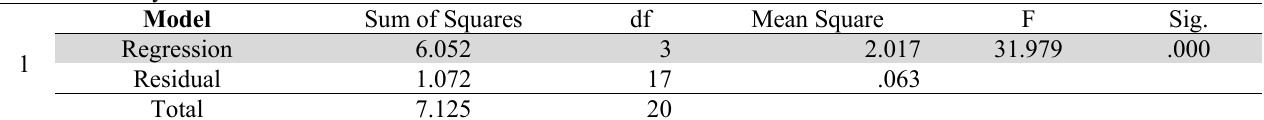
ANOVA Analysis – Model 1- ROA